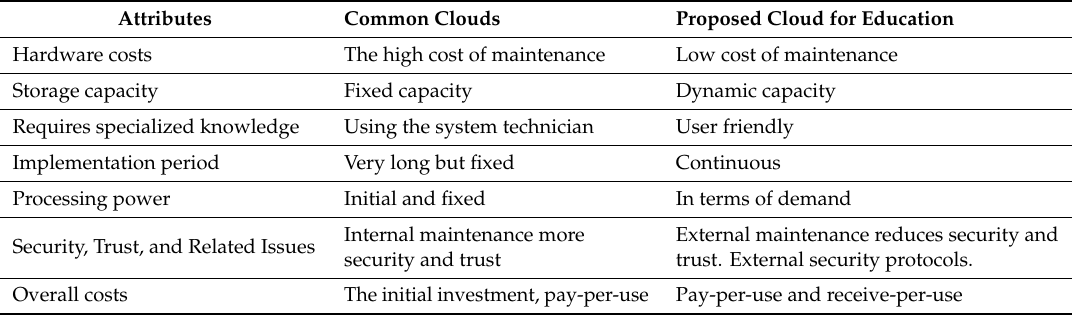
Table 4. Common cloud computing attributes for education.